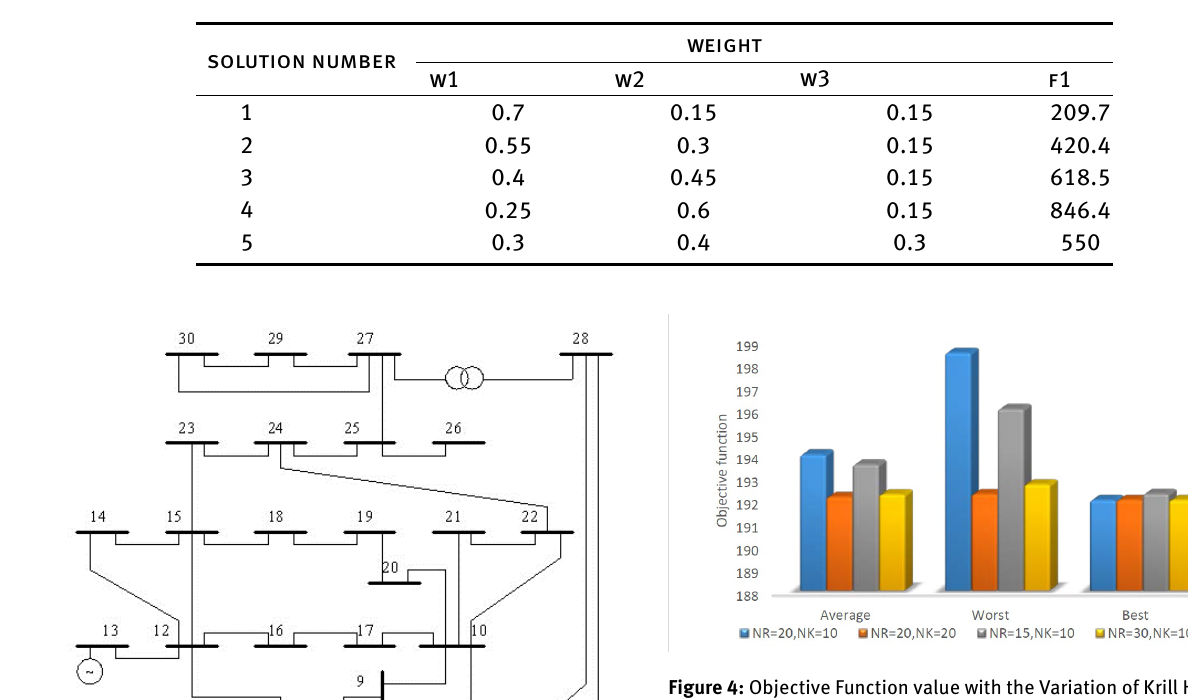
Table 2: Non dominant solutions for Cost, Losses and Voltage deviation objectives krill